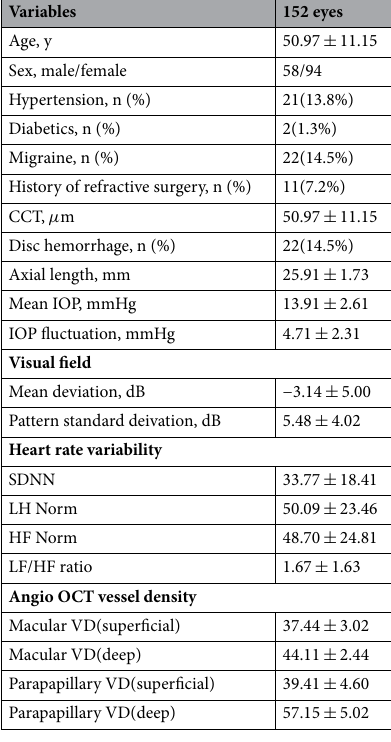
Table 1. Demographics of patients with glaucoma. CCT = central corneal thickness; IOP = intraocular pressure; SDNN = Standard deviation of NN-interval; LF = Low frequency ; HF = High frequency ; VD = Vessel density; OCT = Optical coherence tomography. Continuous data are mean ± mean standard deviation unless otherwise